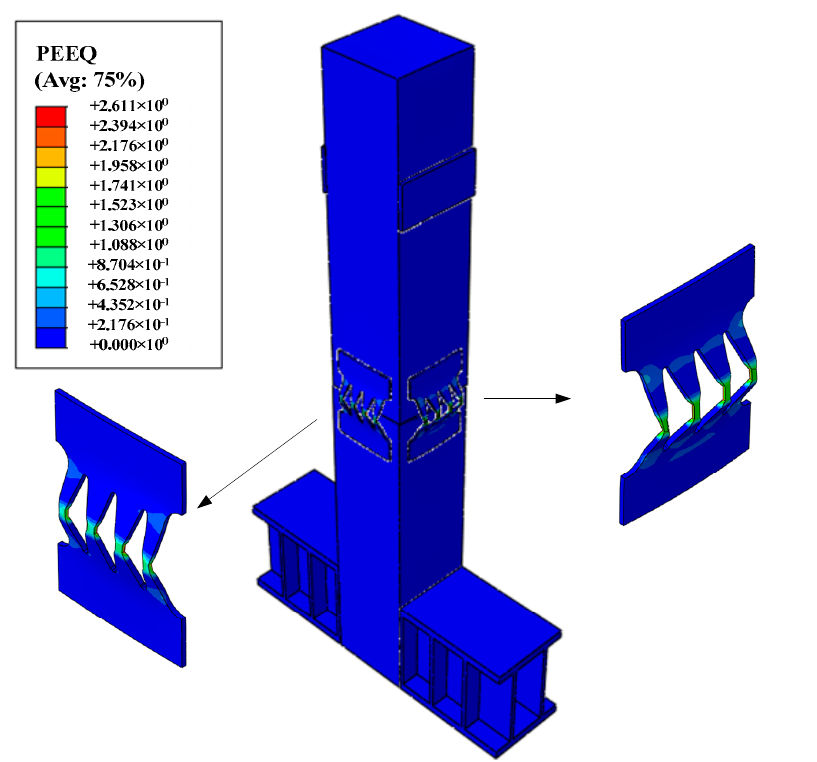
Figure 16. PEEQ (Equivalent plastic strain nephogram).